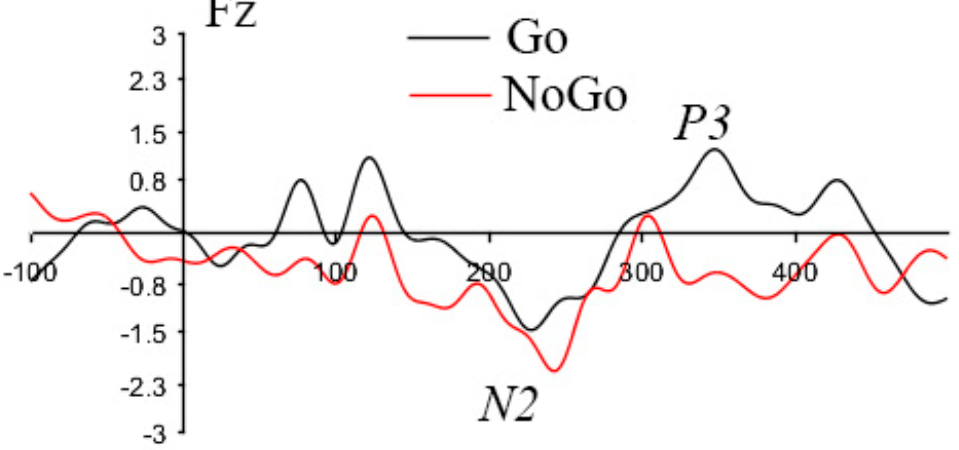
Figure 4. ERP waveform on Fz channels. Data are from the grand average of all subjects in the pre-treatment session.